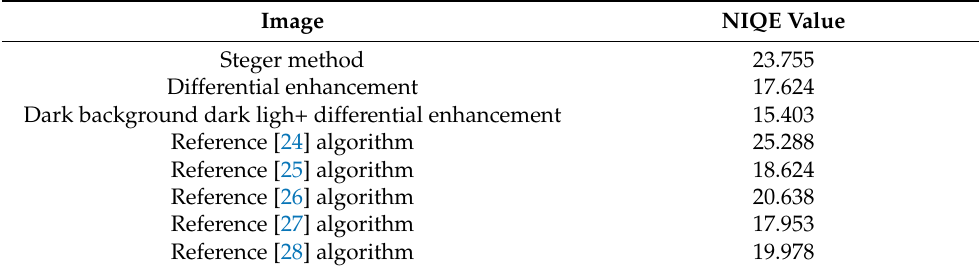
Table 2. Each algorithm process PCB image NIQE value. Image NIQE Value